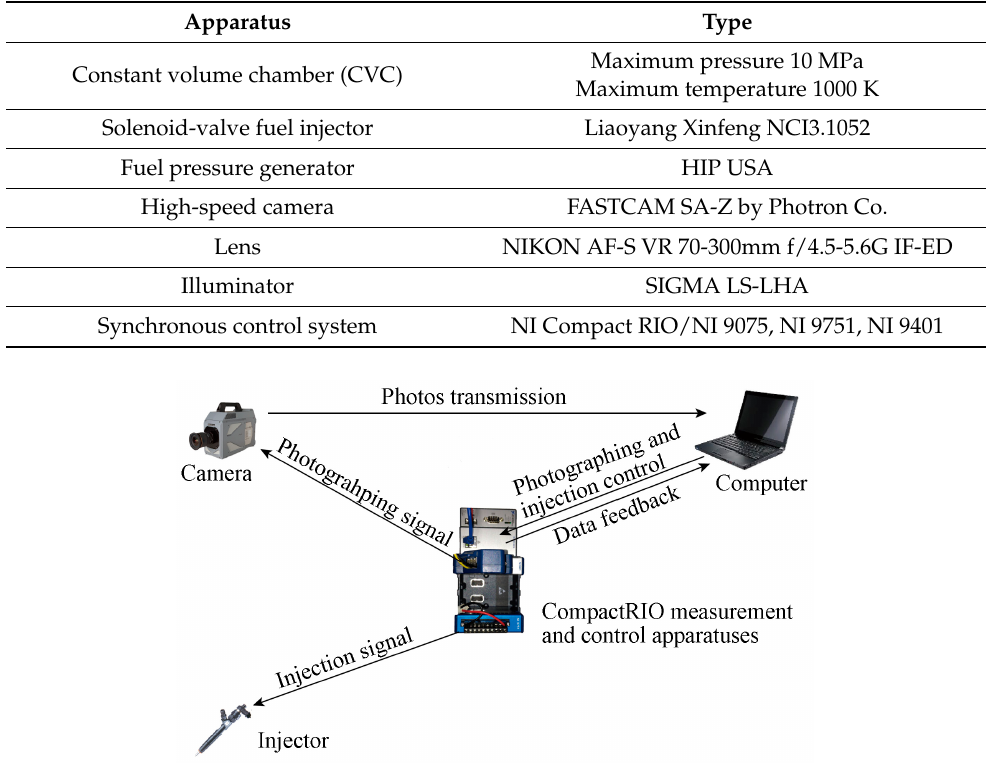
Figure 5. Control logic and running mode of the synchronous control system.